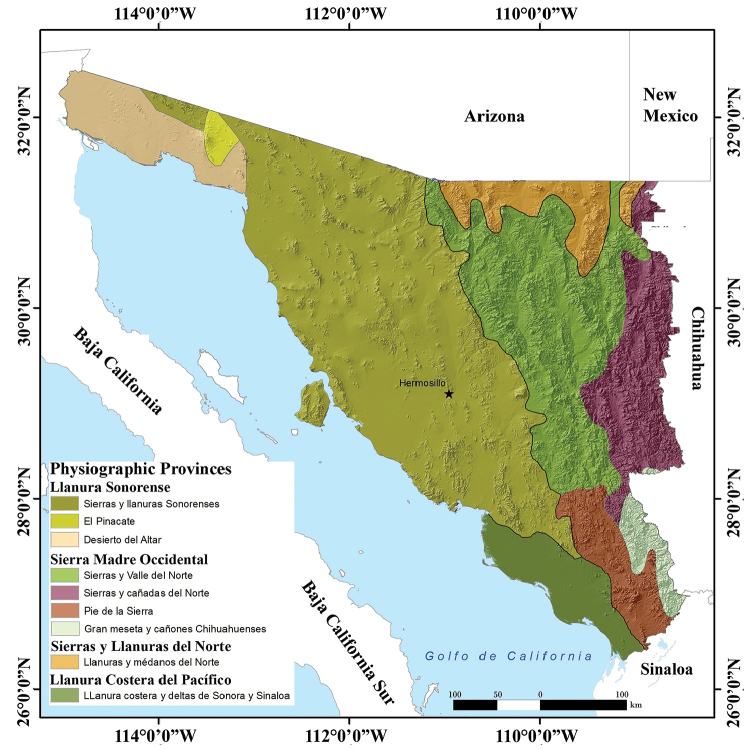
Topographical map with physiographic provinces of the state of Sonora, Mexico. Map modified from Cervantes-Zamora et al. (1990).